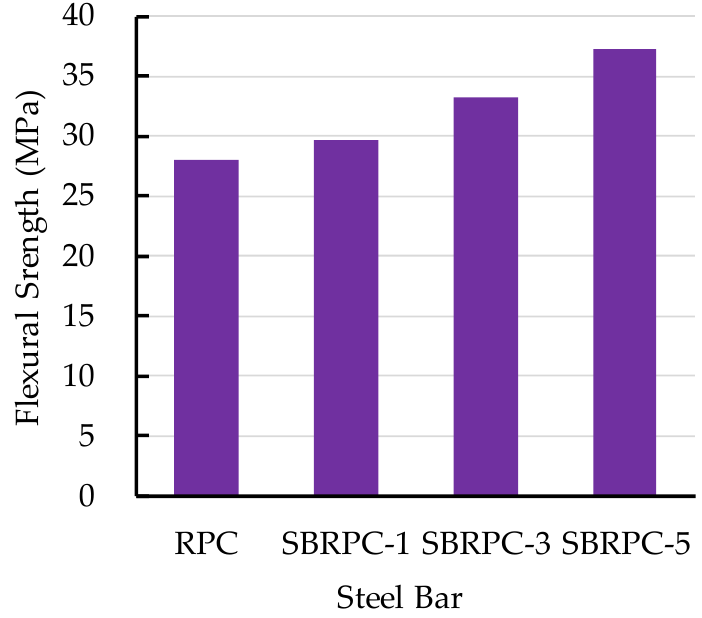
Figure 5. The effect of a steel bar on the flexural strength of SBRPC.